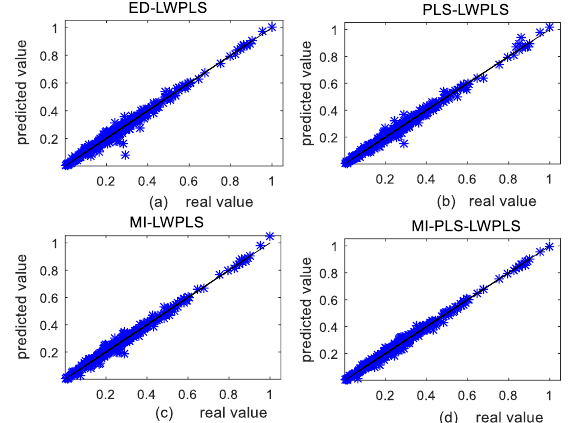
Figure 7. Comparison of prediction scatter plots for the test set of the four methods: ( a ) ED-LWPLS; ( b ) PLS-LWPLS; ( c ) MI-LWPLS; ( d ) MI-PLS-LWPLS.